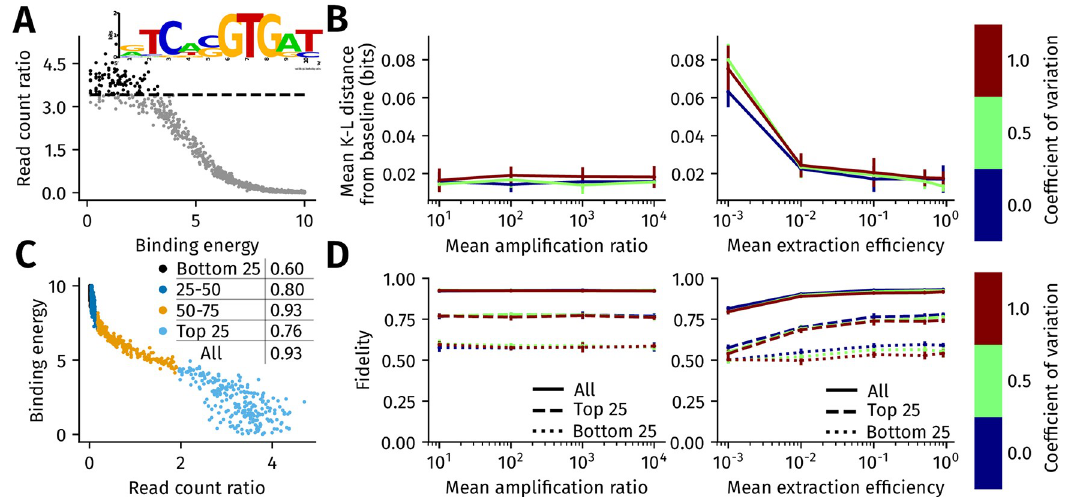
Fig 2. Impact of genome-wide heterogeneity in extraction and PCR efficiency on motif inference and ChIP-seq fidelity. (A) To simulate motif inference, 1000 binding energies were sampled from the default binding energy distribution. A binding site sequence of transcription factor Tye7 was assigned to each binding energy (Methods). After simulating ChIP-seq in the absence of extraction and amplification ratio heterogeneity, binding sites from locations with the 100 highest read count ratios were used to construct a baseline PWM of Tye7 (shown inset). (B) The mean K-L distance between the baseline PWM and the motif inferred in the presence of heterogeneity in extraction efficiency (right) and amplification ratio (left). The heterogeneity in extraction efficiency and amplification ratio is assumed to follow a truncated normal distribution, with the mean increasing from left to right on the x-axis in both panels. The coefficient of variation of the truncated normal varies from 0 (no variation, in blue) to 0.5 (green) and 1.0 (brown). The error bars are the standard deviation in the mean K-L distance computed after PWM was estimated in 10 replicates of ChIP-seq for each mean and coefficient of variation. (C) ChIP-seq fidelity captures the monotonicity of the relationship between read count ratio and binding energy. Fidelity is defined as the probability that if a location i has a read count ratio at least 10% higher than location j , then it implies that i has a lower binding energy than j . Fidelity is calculated by sampling 1000 pairs of locations, where each pair could be from anywhere in the genome or top 25th, 25-50th, 50-75th, or bottom 25th percentiles of the read count ratio. Read count ratios falling in each percentile bin are marked in different colors in the scatter plot. The fidelity values in each of these bins is shown in the plot legend, along with the fidelity computed across all regions. (D) Variation in ChIP-seq fidelity with heterogeneity in extraction efficiency (right) and PCR amplification ratio (left). The x-axis and the three plot colors are defined identically to B. The error bars are the standard deviation in the estimate of fidelity, which are computed from 10 replicates of simulation for a given mean and coefficient of variation.